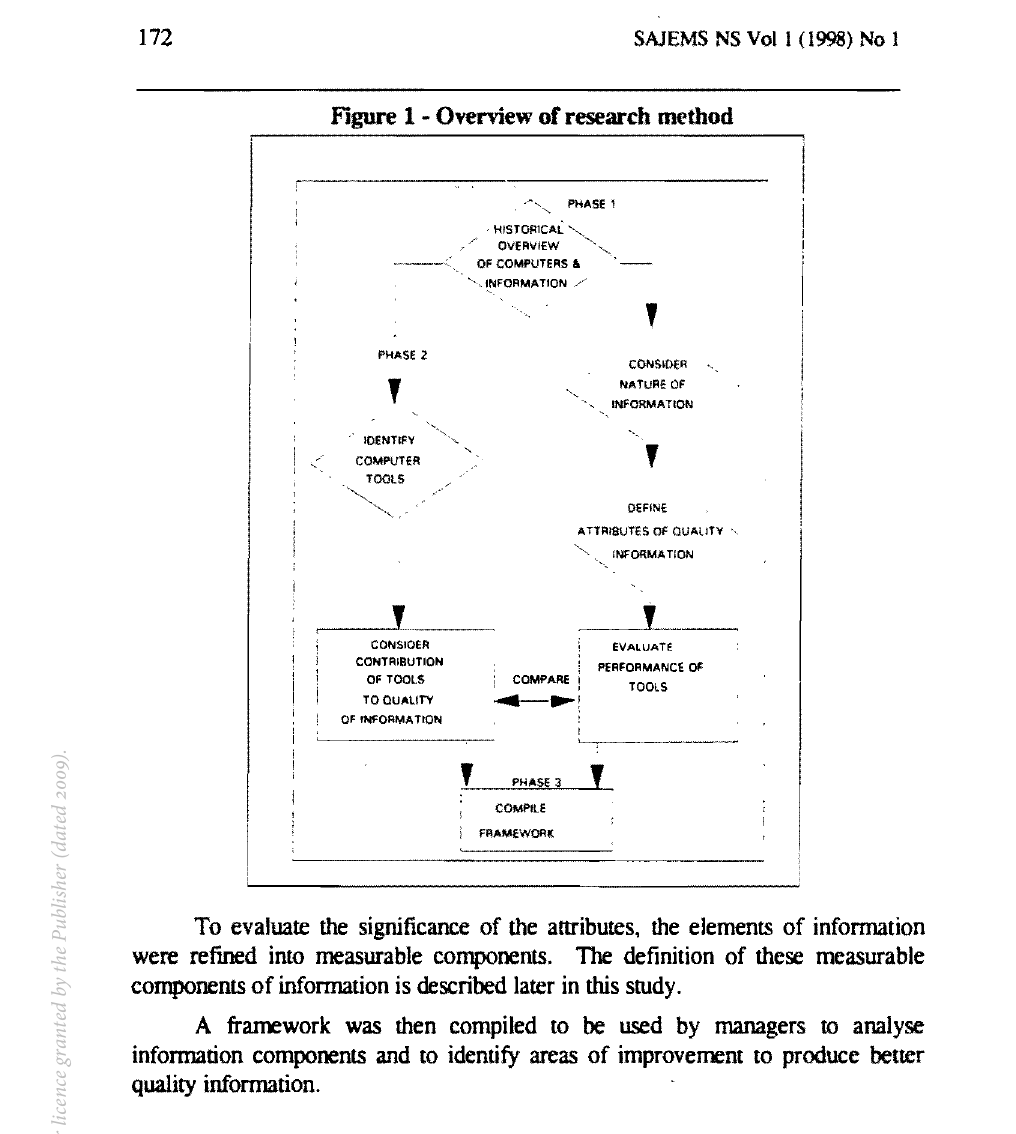
Figure 1 - Overview or research